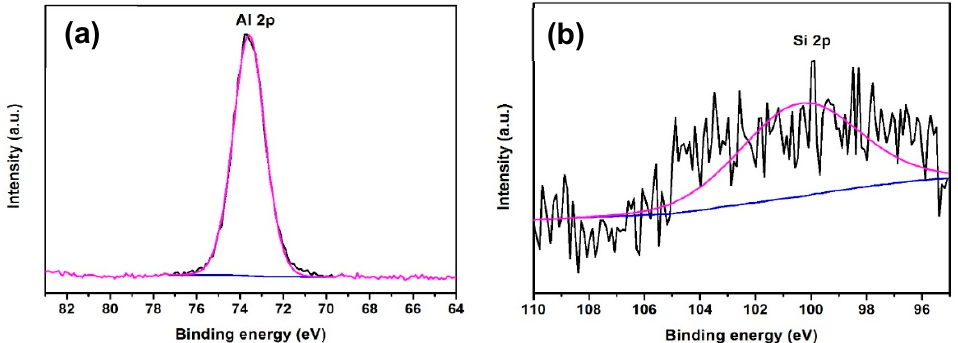
Figure 2. High resolution XPS spectra of ( a ) Al 2p and ( b ) Si 2p of Al 2 O 3 film deposited on glass via CVD.